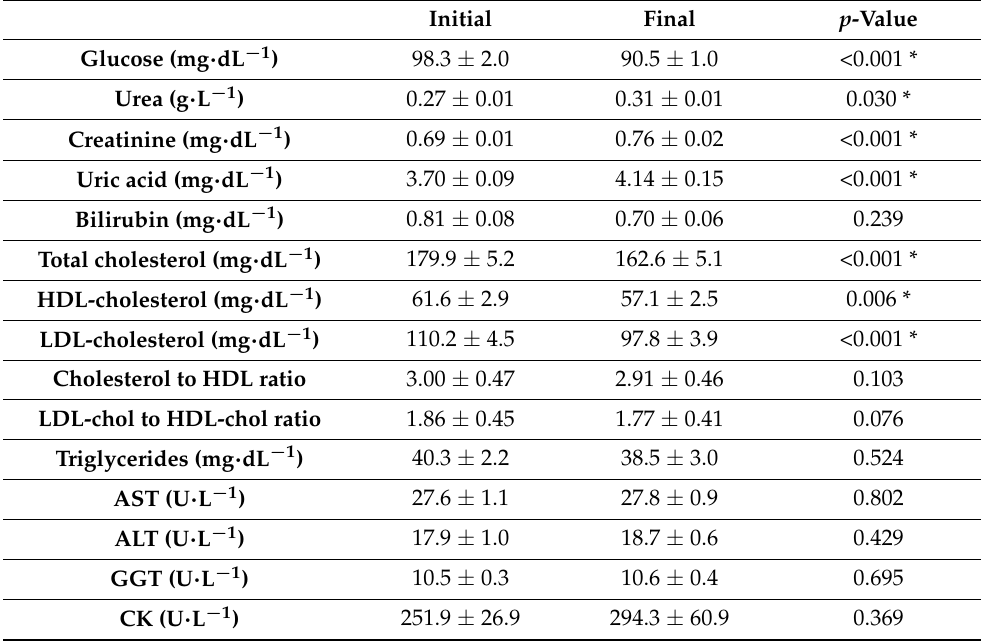
Table 4. Changes in serum biochemical parameters during the study.